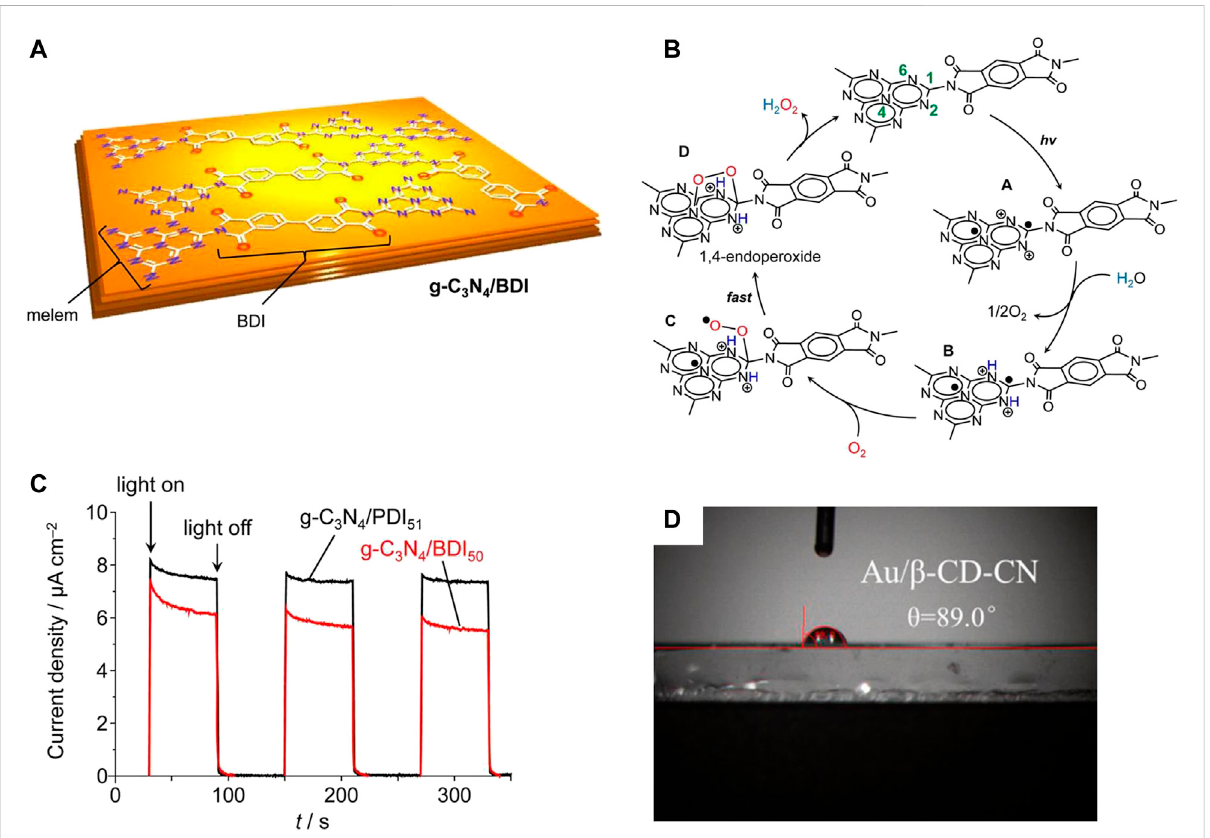
FIGURE 4 (A) Three-dimensional structure of g-C 3 N 4 /BDI. (B) Proposed Mechanism for H 2 O 2 Formation on the Photoexcited g-C 3 N 4 /BDI Catalyst. (C) Photocurrent response of g-C 3 N 4 /BDI 50 and g-C 3 N 4 /PDI 51 in 0.1 M Na 2 SO 4 solution under visible light ( λ > 420 nm) at a bias of 0.5 V vs. Ag/AgCl (Kofuji et al., 2016). (D) The water contact angle of Au/ β -CD-CN (Zuo et al.,